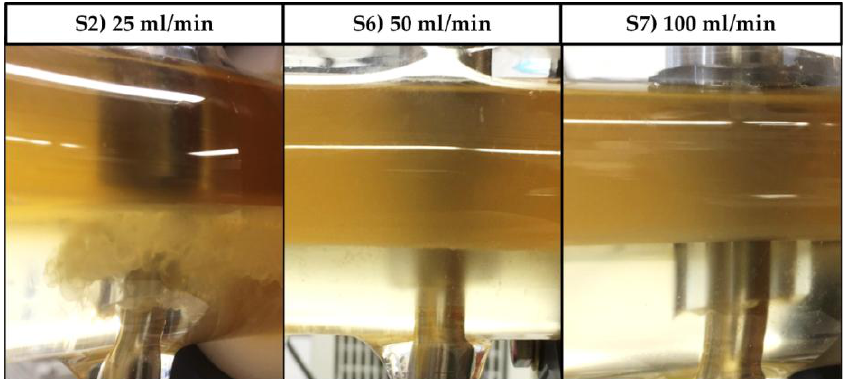
Figure 12. Exit area of the DN50 settler at three different flowrates but an otherwise identical set-up (DN: Diameter nominal). In experiment S2, cells can be retrieved together with heavy phase through bottom phase exiting (left).